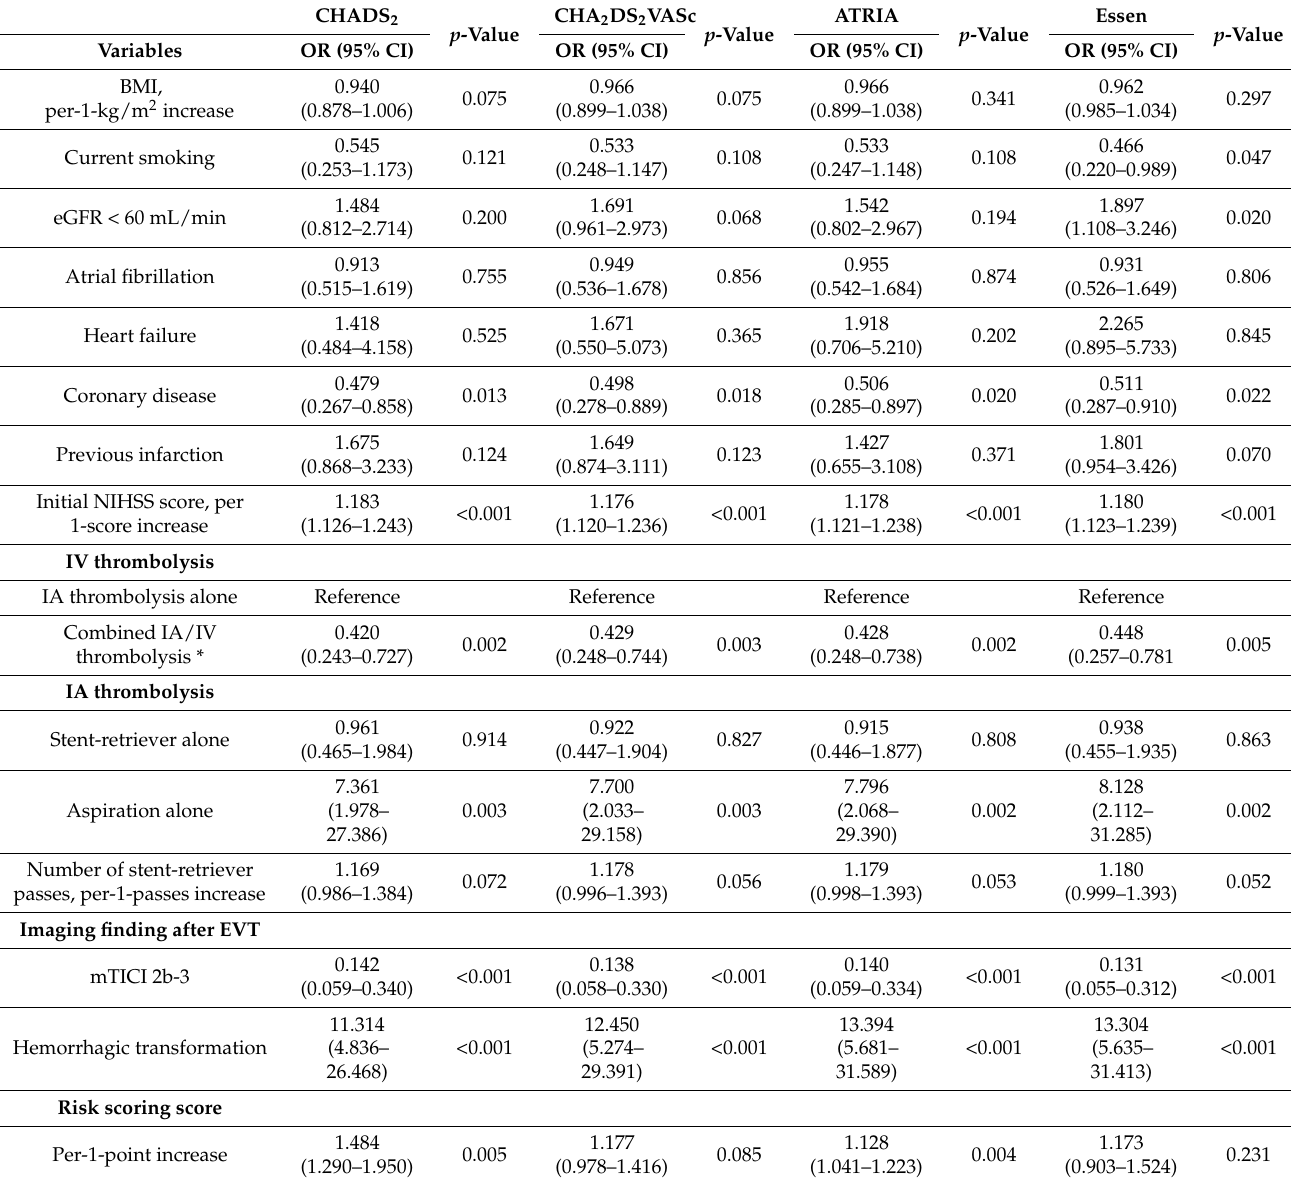
the CHA 2 DS 2 -VASc score tended to be associated with unfavorable outcomes (Table S3). Table 2. Multivariate analysis for stroke risk score correlated with the unfavorable outcome among 404 patients with EVT (Model